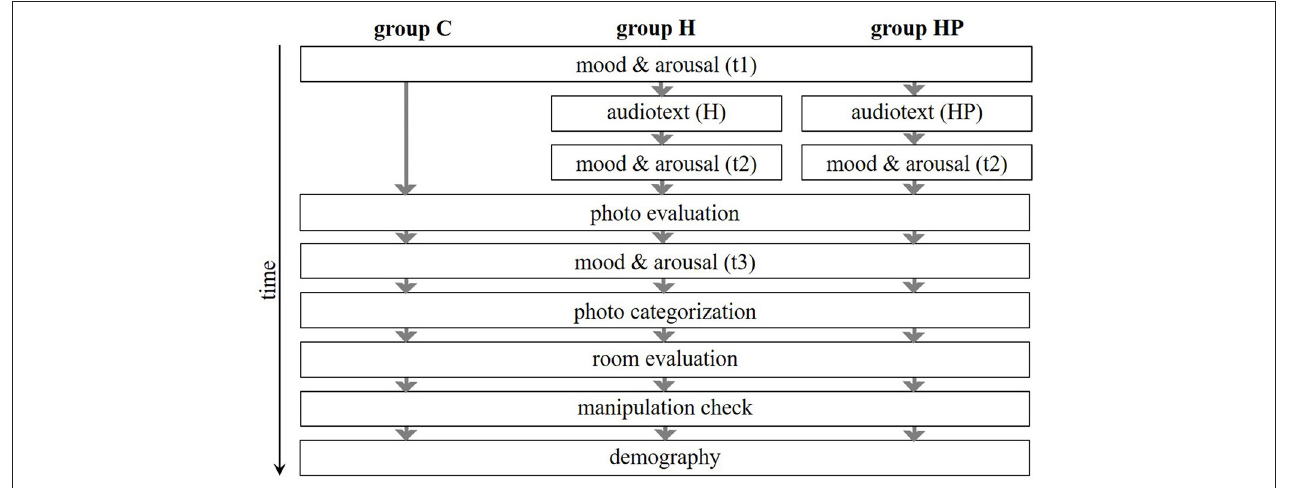
FIGURE 1 | Procedure of Study 1. C, control group; H, history awareness group; HP, history and place awareness group.